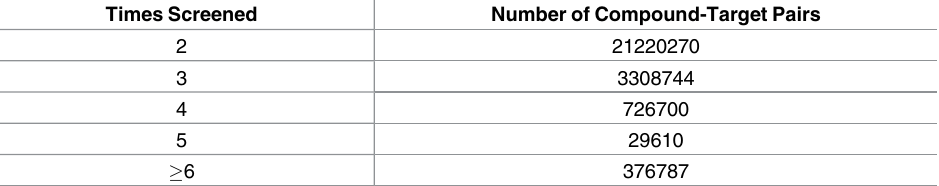
Table 2. Screening Frequency. The number of distinct compound-target combinations screened in multiple assays, listed for increasing numbersof assays. Times